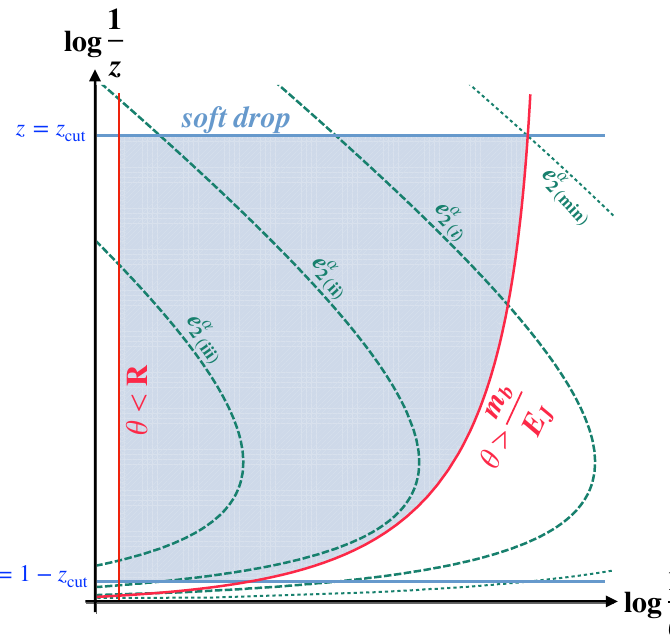
Figure 6 . The phase space for integration in the ln(1 /θ ) , ln(1 /z ) plane at boundaries are determined by the jet radius ( R ), the soft drop condition ( z angle at which a quark of nonzero mass m space region is shaded. The dotted line is the smallest allowed value e ( α ) angle. The dashed lines are lines of constant e ( α )